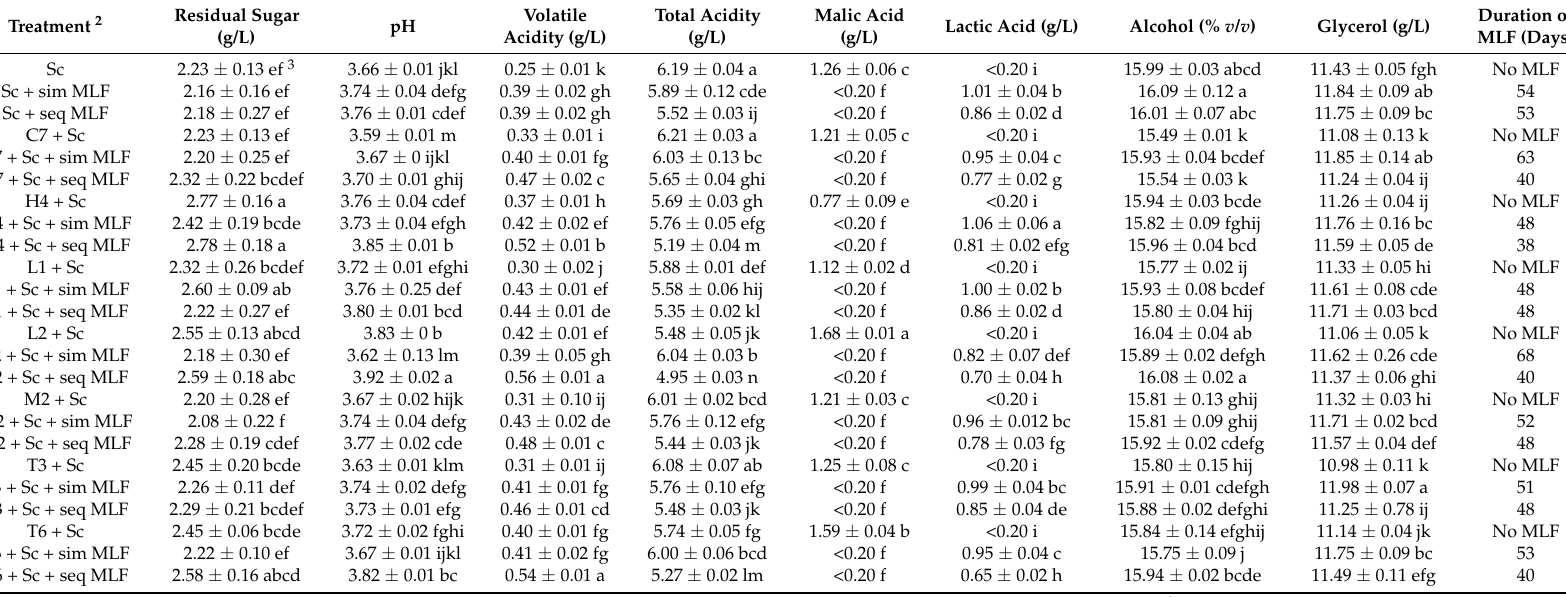
Table 2. Standard chemical parameters and duration of malolactic fermentation (MLF) of Shiraz juice 1 and wines produced with Saccharomyces and non- Saccharomyces yeasts in combination with MLF strategies (none, simultaneous and sequential). Values are averages of three